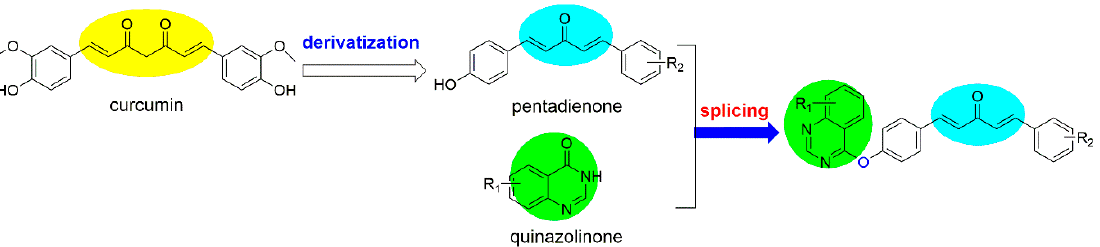
Figure 1. Design of the target compounds. The yellow circle represents the modifiable structure part of curcumin, the blue circles represent the structure part of pentadienone, and the green circles represent the structure part of quinazolinone.